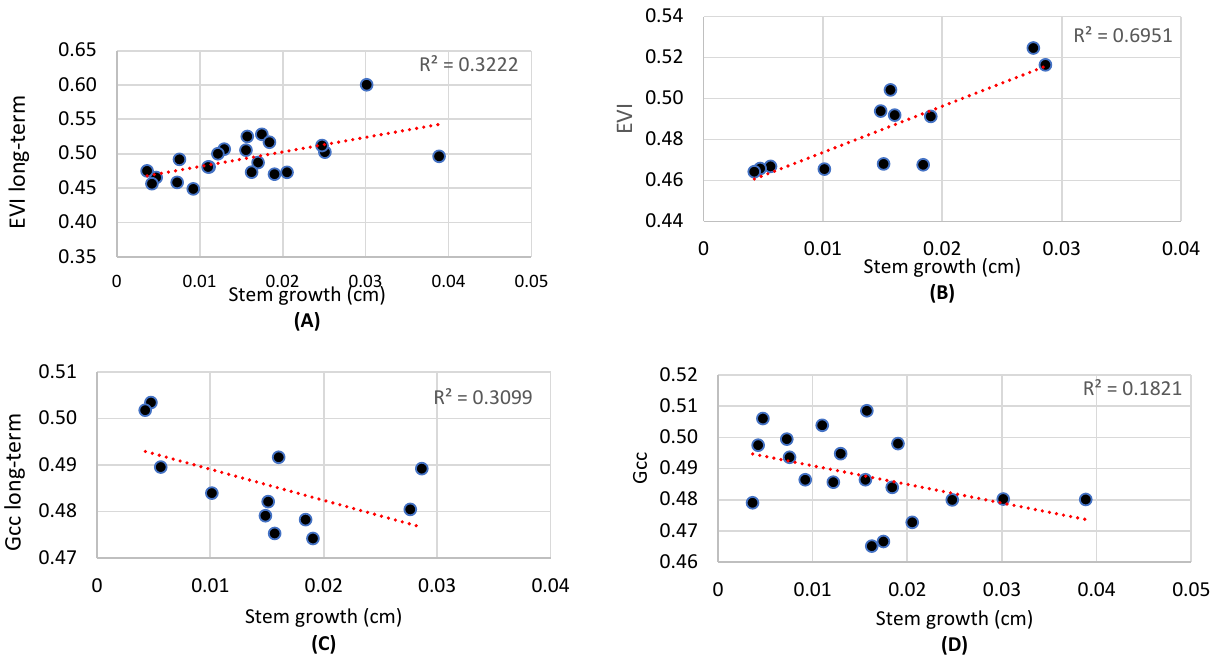
Figure 3. Relationship between in situ and remote sensing data, RJA site. ( A ) EVI × Stem growth; ( B ) EVI (2000 – 2017) × Stem growth (2015 – 2017) monthly long-term average; ( C ) Gcc (2000 – 2017) × Stem growth (2015 – 2017) monthly long-term average; ( D ) Gcc × Stem growth.